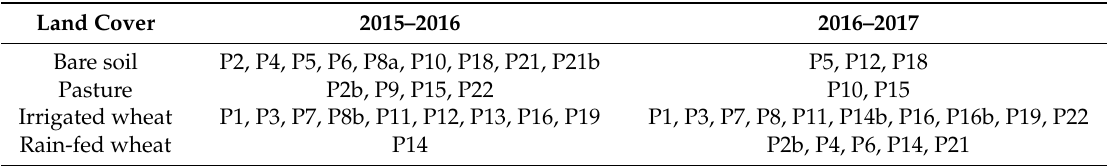
Figure 2. Location of reference fields on the study site (Landsat image). Table 1. Land cover during 2015–2017.